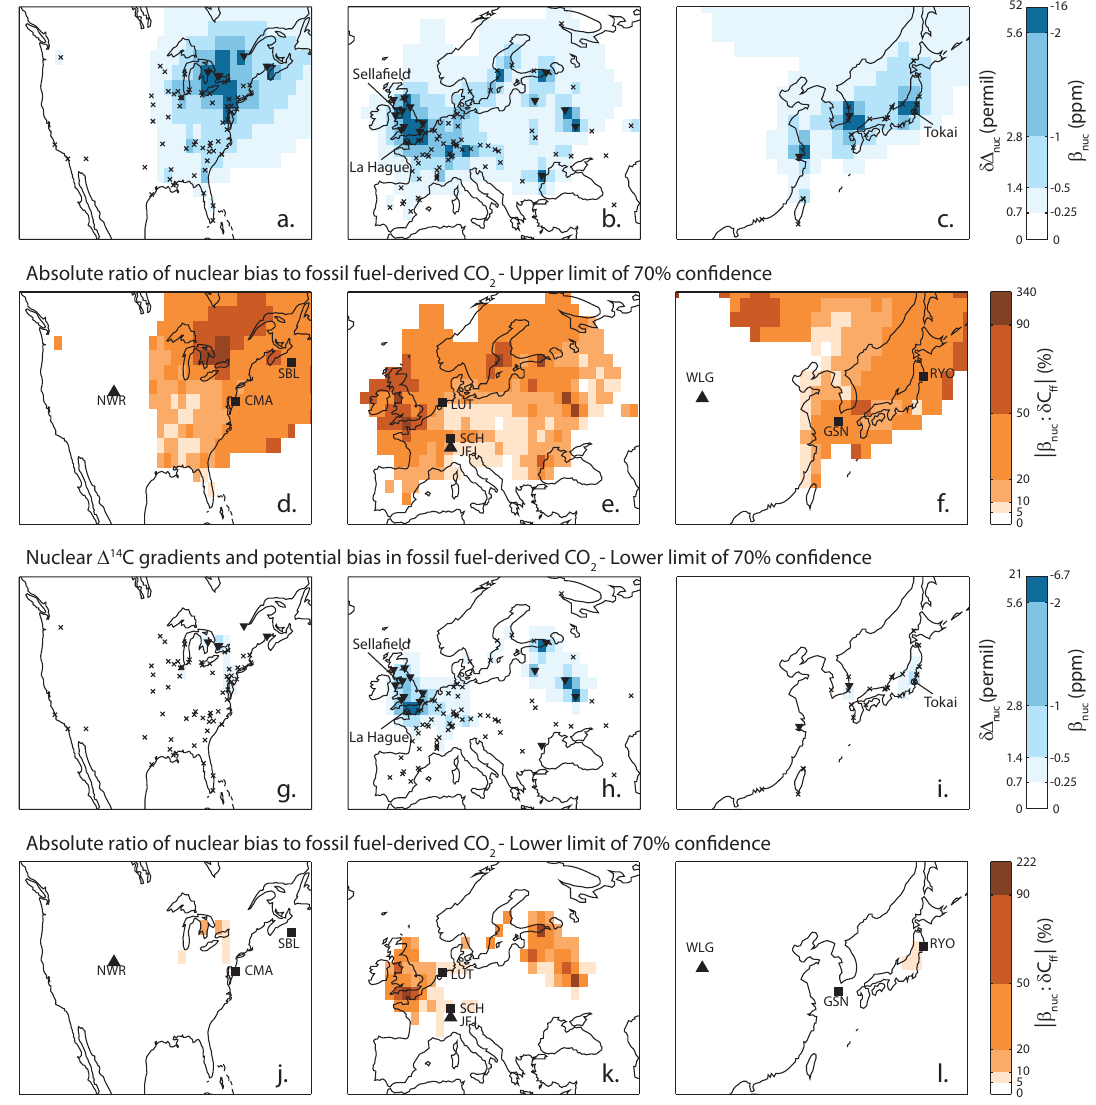
Fig. 3. Results from transport model simulations of 14 C emissions for 2005 estimated using emission factors at the upper and lower limits of the 70% confidence intervals as shown in Fig. 1. Nuclear 1 14 C enhancement ( δ1 nuc ) and potential nuclear bias to fossil fuel-derived CO 2 ( β nuc ) for emissions at the upper (a–c) and lower (g–i) limits of 70% confidence. The ratio | β nuc : δC ff | , in percent, shown only in grid cells where β nuc was less than − 0 . 25ppm for emissions at the upper (d–f) and lower (j–l) limits of 70% confidence.